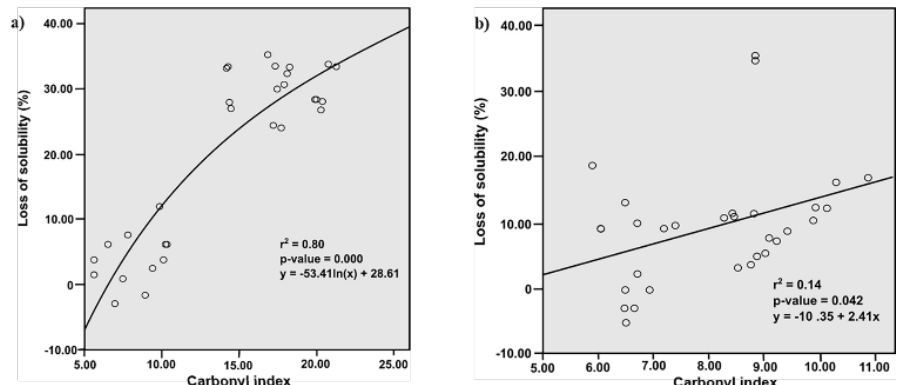
Figure 4. Effect of carbonylation on loss of solubility. It was evaluated through ( a ) logarithmic regression in sarcoplasmic proteins and ( b ) simple linear regression in myofibrillar proteins. The model was significant to p < 0.05 .